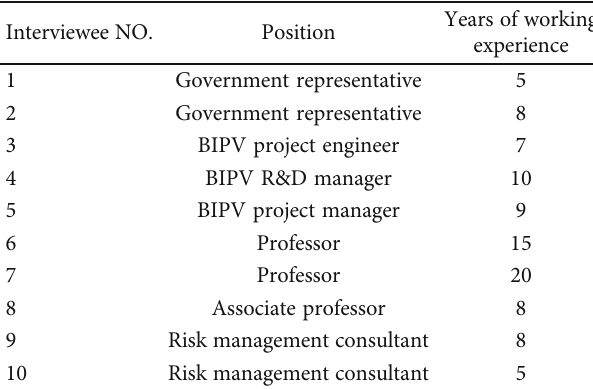
Table 1: List of risk indicators preliminarily identi fi ed. Table 2: Information of the